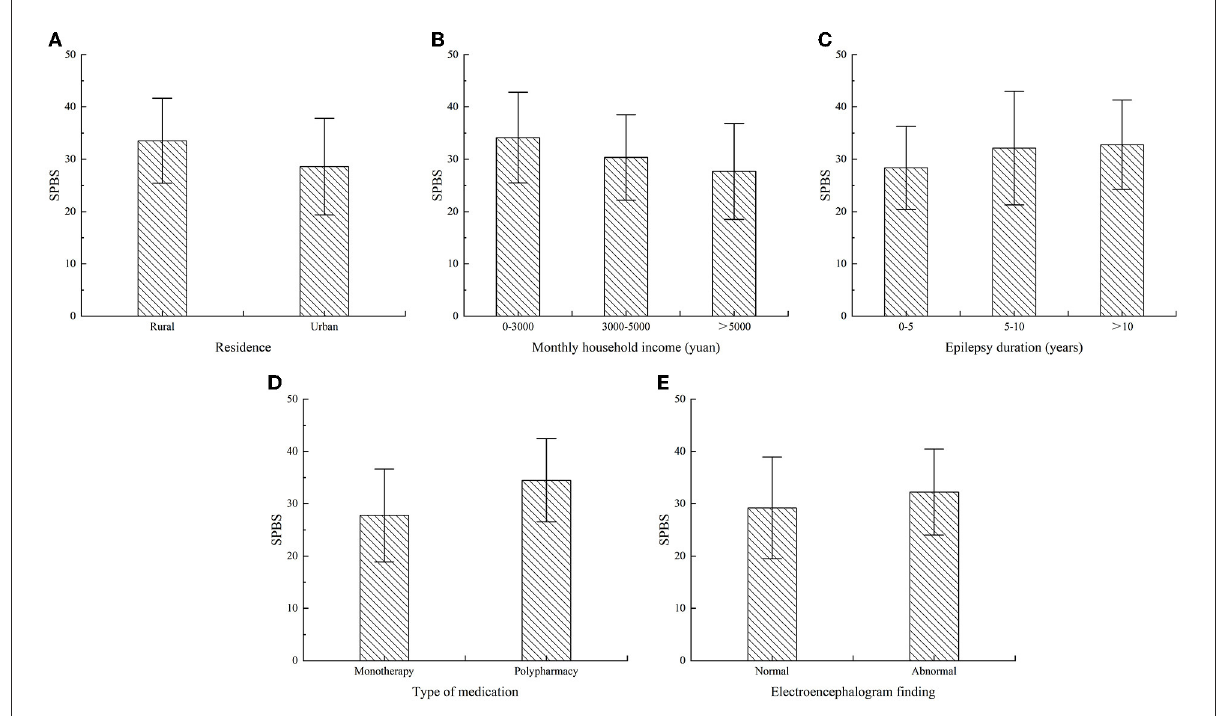
FIGURE1 Error bar graph of SPBS score in each group in each group (N=143).